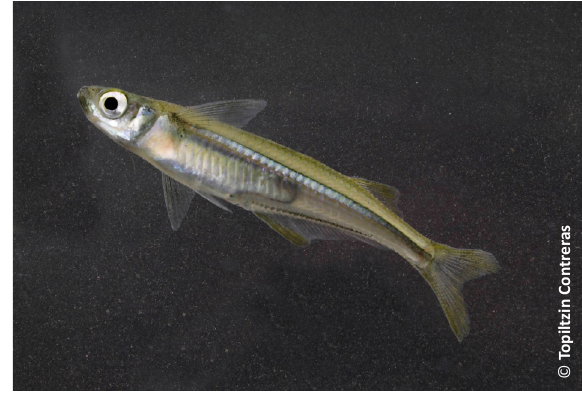
Image 5. Atherinella sp. (Silverside) from an unknown